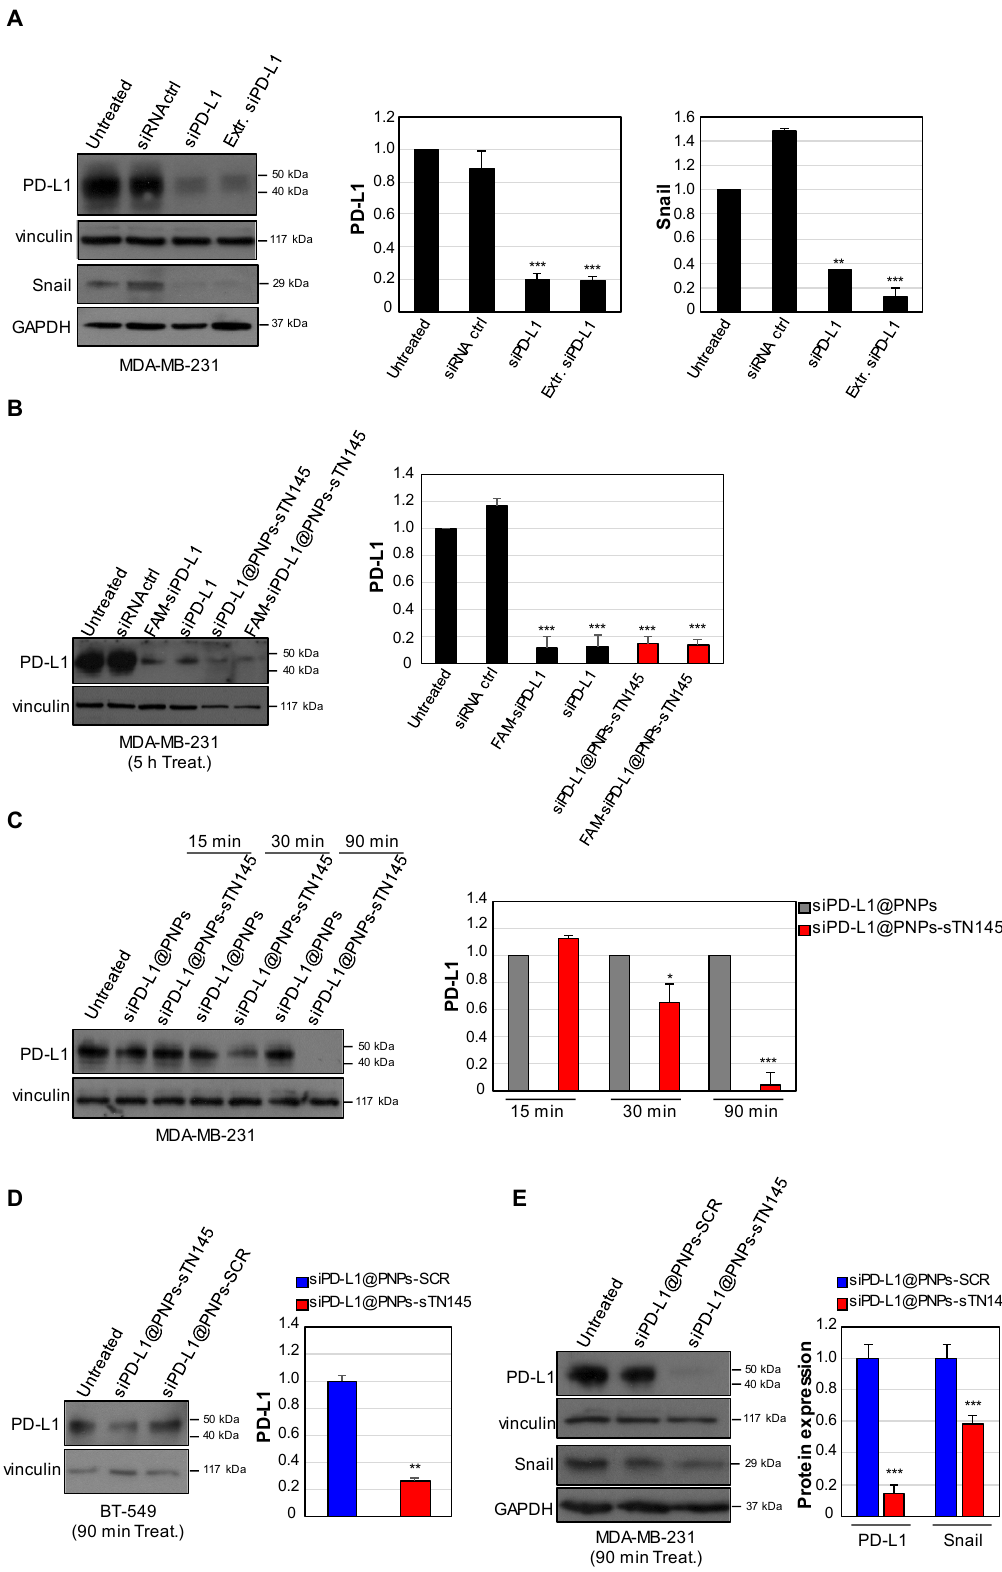
Figure 5. sTN145-conjugated nanoparticles deliver PD-L1 siRNA into TNBC cells. MDA-MB-231 cells were left untreated or transfected with 30 nM PD-L1 siRNA either naked (siPD-L1), FAM-labeled (FAM-siPD-L1), or extracted from siPD-L1@PNPs (Extr. siPD-L1), using Lipofectamine reagent. Nonsilencing siRNA (siRNA ctrl) was used as a control ( A , B ). MDA-MB-231 ( B , C , E ) and BT-549 ( D